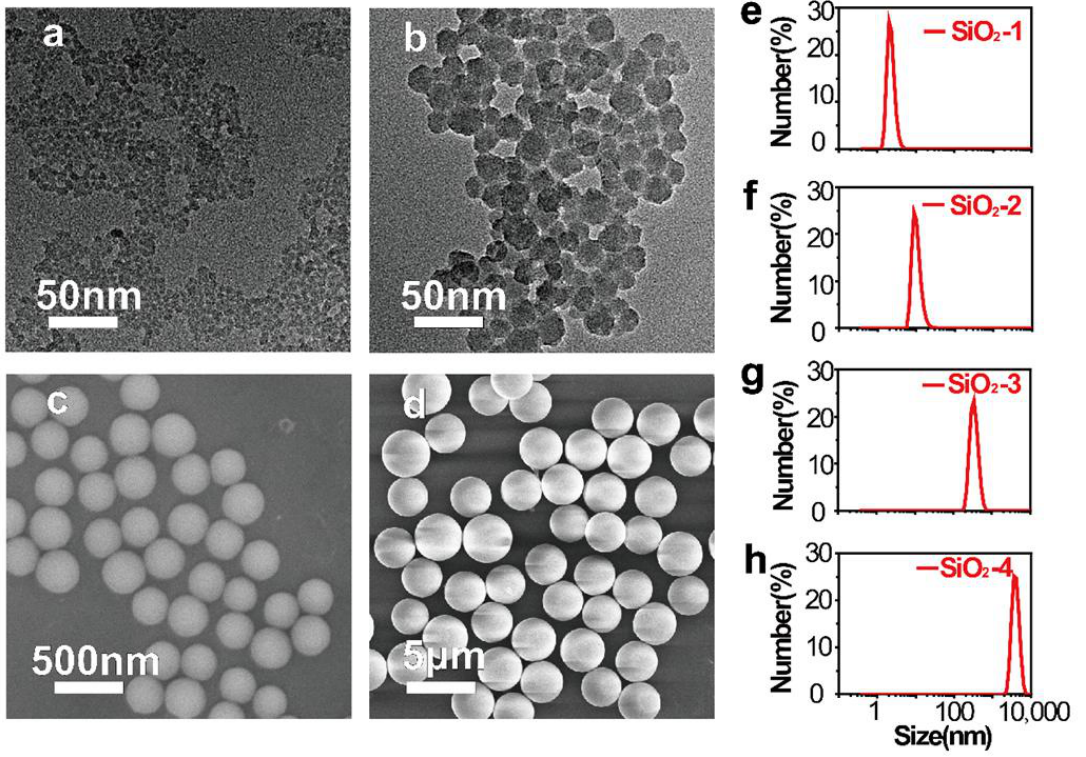
Figure 1. ( a , b ) TEM images of SiO 2 -1 (6 nm) and SiO 2 -2 (20 nm); ( c , d ) SEM images of SiO 2 -3 (300